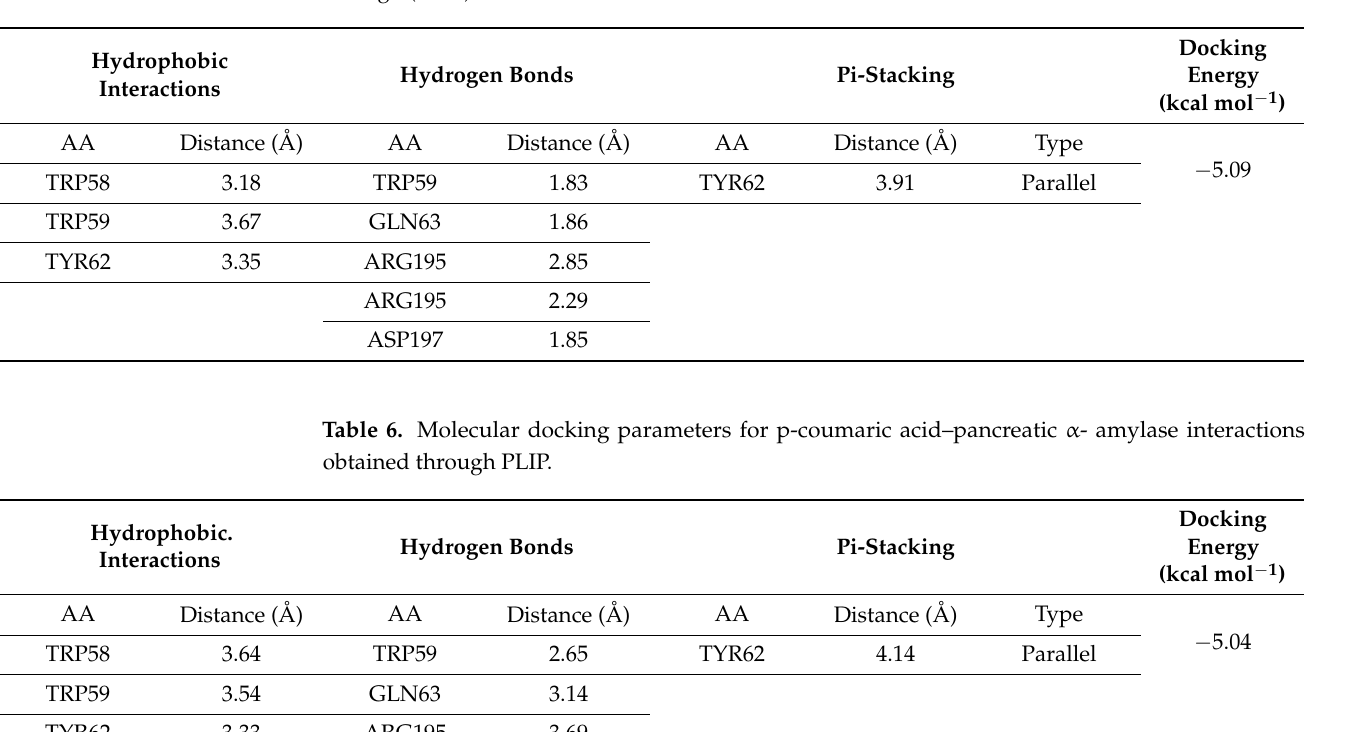
Table 5. Molecular docking parameters for caffeic acid–pancreatic α - amylase interactions obtained through (PLIP).